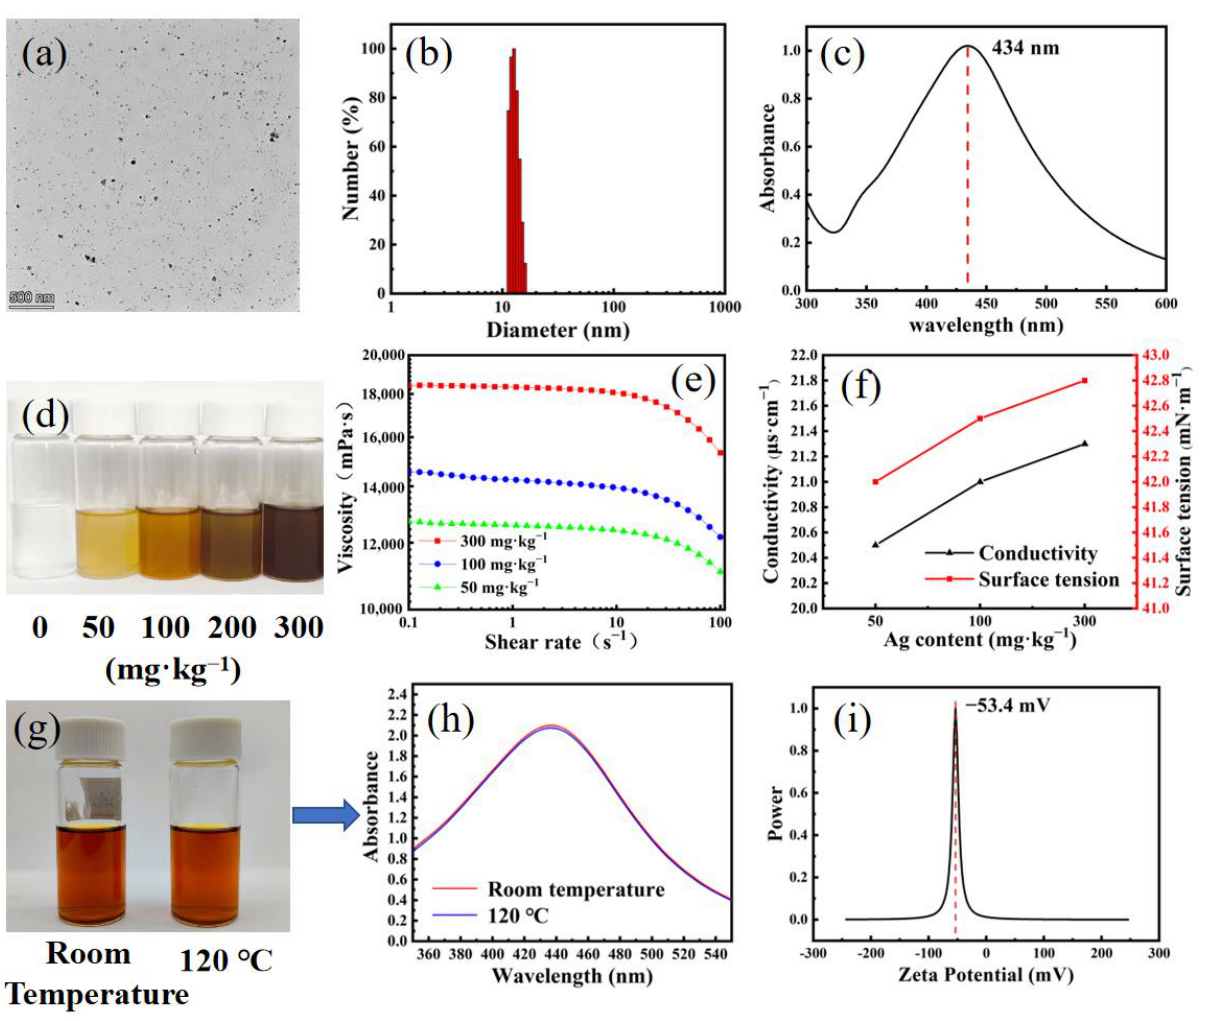
Figure 1. ( a ) TEM image, ( b ) particle size distribution, and ( c ) UV – vis spectrum of AgNP solution. ( d ) Photos of TPU solutions with gradient Ag content. ( e ) Viscosity of TPU solutions. ( f ) Conductiv- ity and surface tension of TPU solutions with Ag content range of 50 – 300 mg·kg −1 . ( g ) Images and ( h ) UV – vis spectra of WPU-capped AgNPs solutions (30 mg·L −1 ) after treatment at different temper- atures for 2 h. ( i ) Zeta potential of WPU-capped AgNPs.